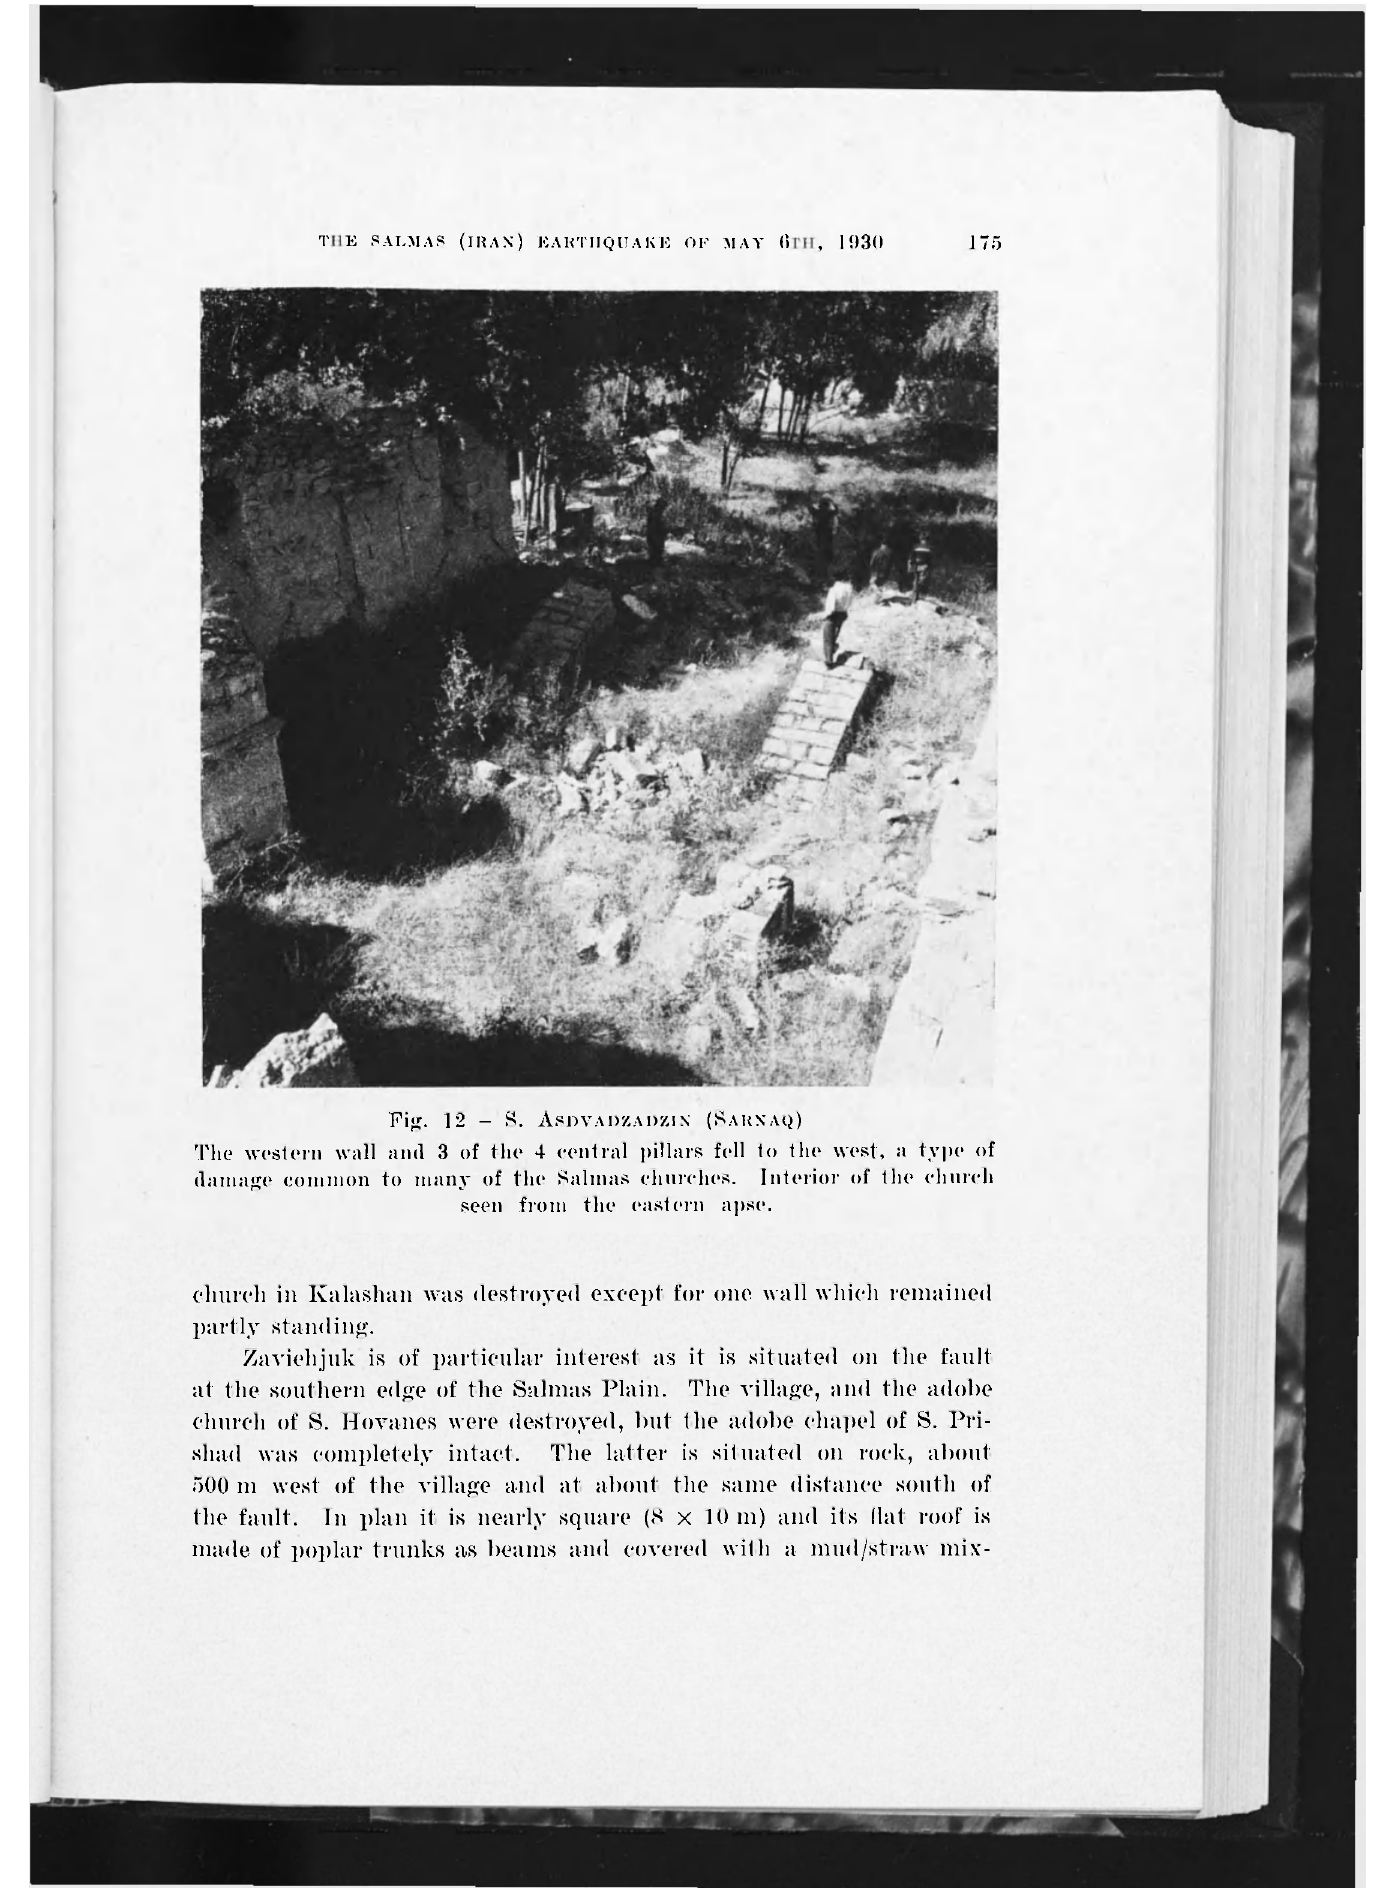
Pig. 12 - S. ASDVADZADZIN